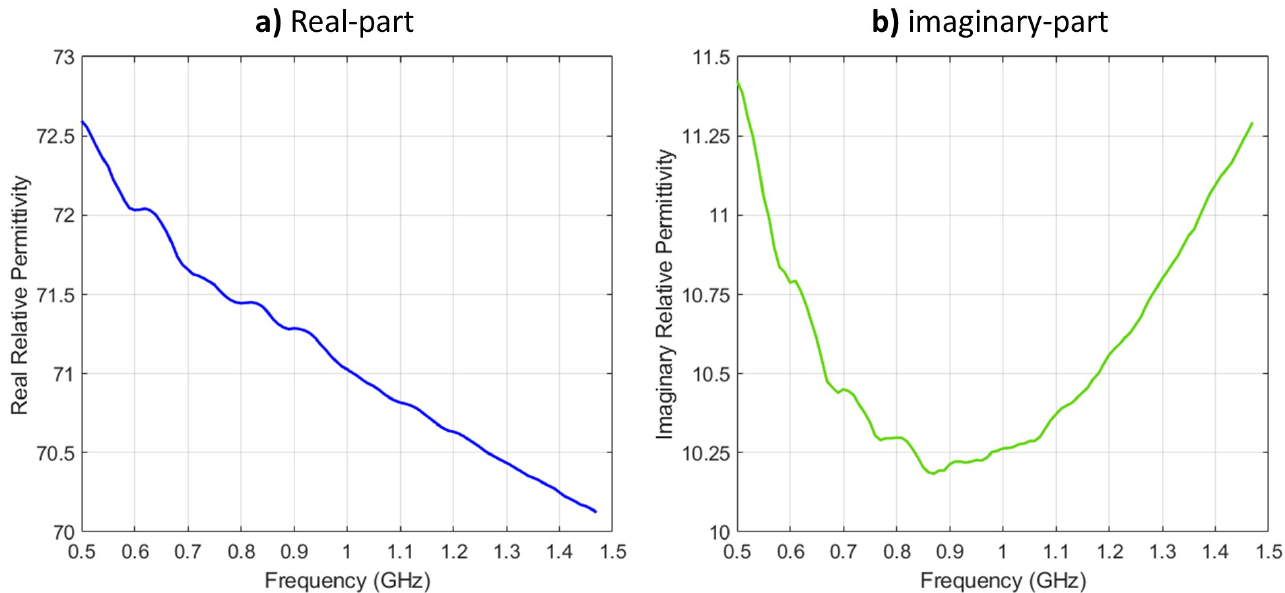
Figure 2. Relative complex permittivity (real and imaginary) of AquaSonic 100 gel: ( a ) real-part and ( b )